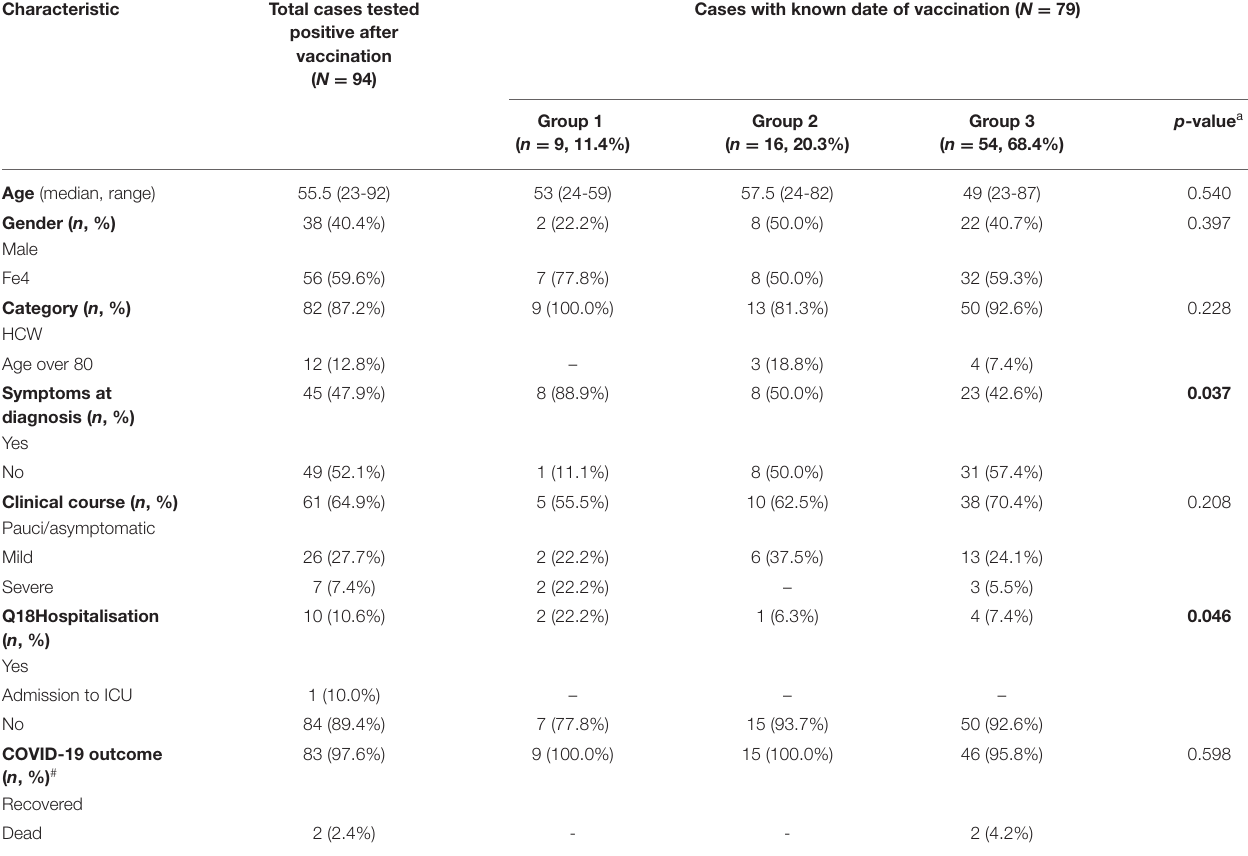
TABLE 1 | Demographic and epidemiological information is available for the study cohort. Characteristic Total cases tested